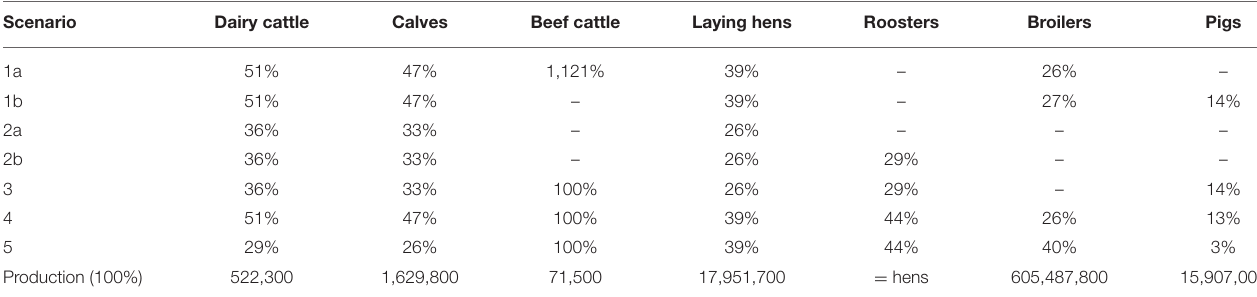
TABLE 6 | Estimated amounts of animals in the livestock production systems needed per year in the different scenarios, extrapolated to the Dutch population. Scenario Dairy cattle Calves Beef cattle Laying hens Roosters